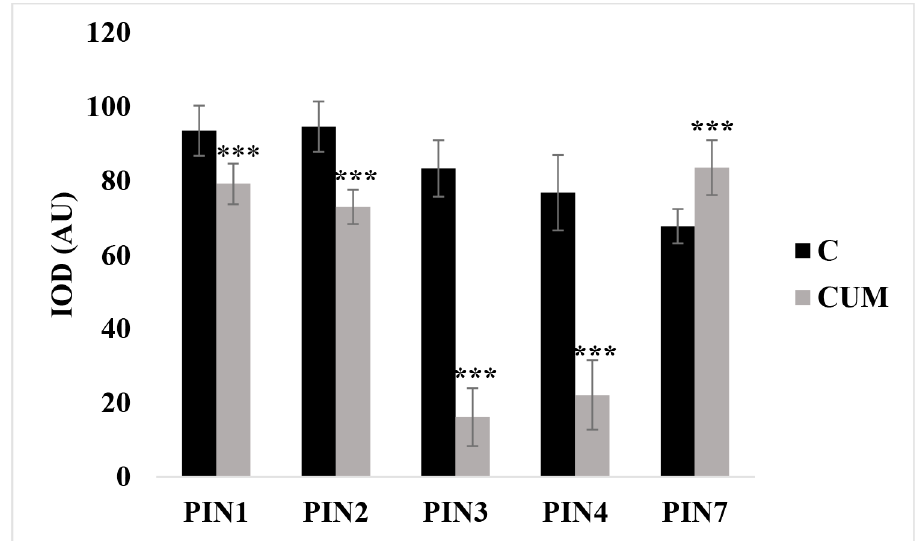
Figure 7. Integrated optical density (IOD) of PINs proteins expressed as arbitrary units (AU) of fluorescence intensity measured on the entire RAM of Arabidosis treated for 48 h with coumarin 0 (C) or 100 (CUM) µM. Data are presented as mean ± standard deviation (SD). Statistical analysis was performed using the Student’s t -test with *** p ≤ 0.001. N = 10.